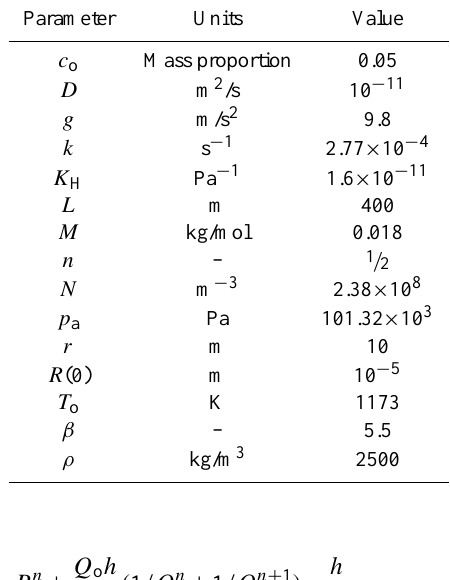
Table 1. Parameter values used in the calculations of Sect. 4.2. These are typical of the Montserrat system (Wylie et al., 1999). The value of β is estimated from the temperature and from the empirical relation (19) (Shaw, 1972). The value of Henry constant K H , the volatile diffusion constant D and the initial bubble radius R (0) are taken from Proussevitch et al. (1993). The bubble number density N is inferred from Proussevitch et al. (1993). Parameter Units Value c o Mass